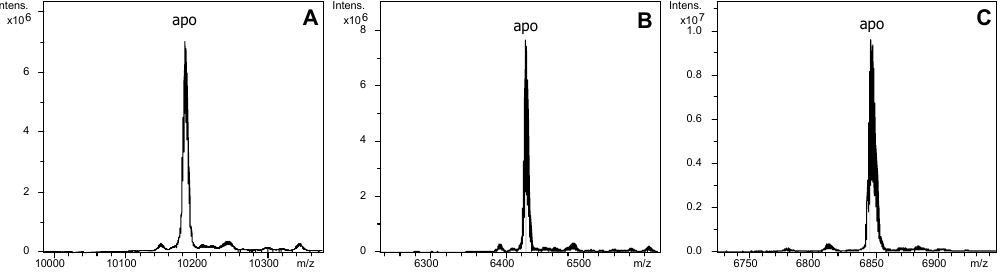
Figure 2. Sequences of the recombinant proteins studied in this work: the constructs Lltr1MT (GeneBank Accession No. MF326202) and Lltr2MT (GeneBank Accession No. MF326203) are aligned with the LlwtMT (UniProt #Q962G0) wild-type form. Cysteine residues are written in red , Methionine residues in blue , and the SSVF N-terminal flanking amino acids are highlighted in green .